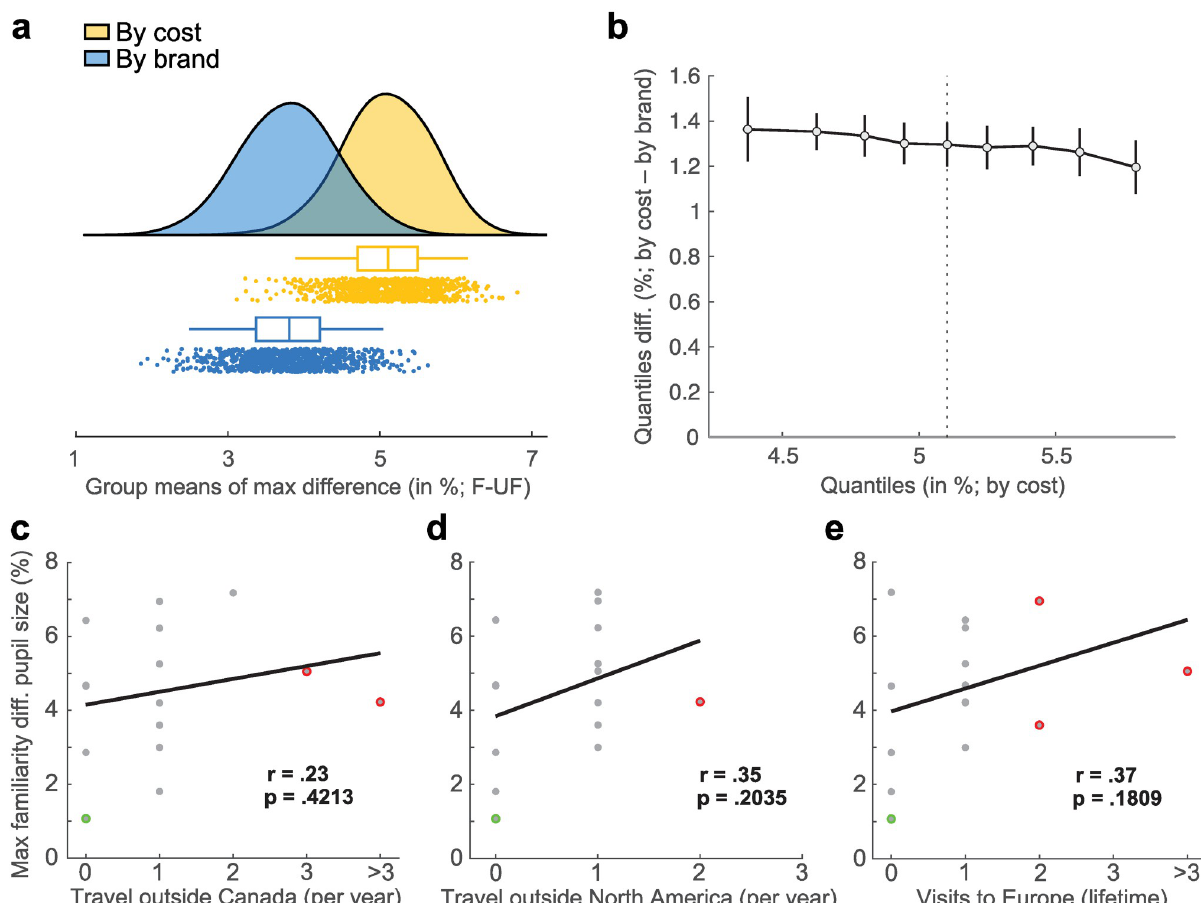
Fig 4. Correlations between pupil data and attention questions. a) Raincloud plot comparing bootstrapped means of subgroups split by self-reported usual product choice preference. Means generated from 1000 bootstrap iterations. b) Robust shift function comparing deciles of the two distributions shown in panel a [35]. The y-axis depicts by how much the “by brand” distribution (blue) has to be shifted along the x-axis to match the “by cost” distribution (yellow). c—e) Bend correlations between individual max pupil dilation difference and self-reported travelling frequency within different global contexts. Colored dots represent downweighted values in the x (red) and y direction (green) respectively. Some single-participant dots may be masked by dots of similar values.